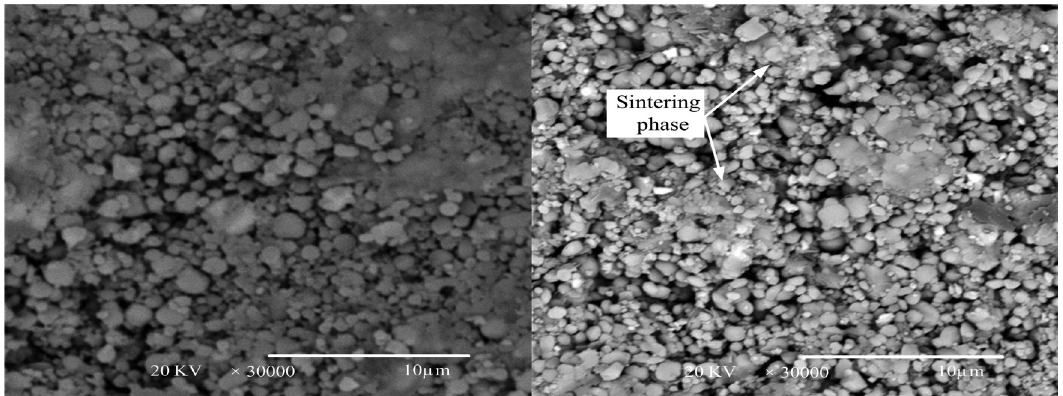
Fig. 7: SEM images of raw sample and roasted sample